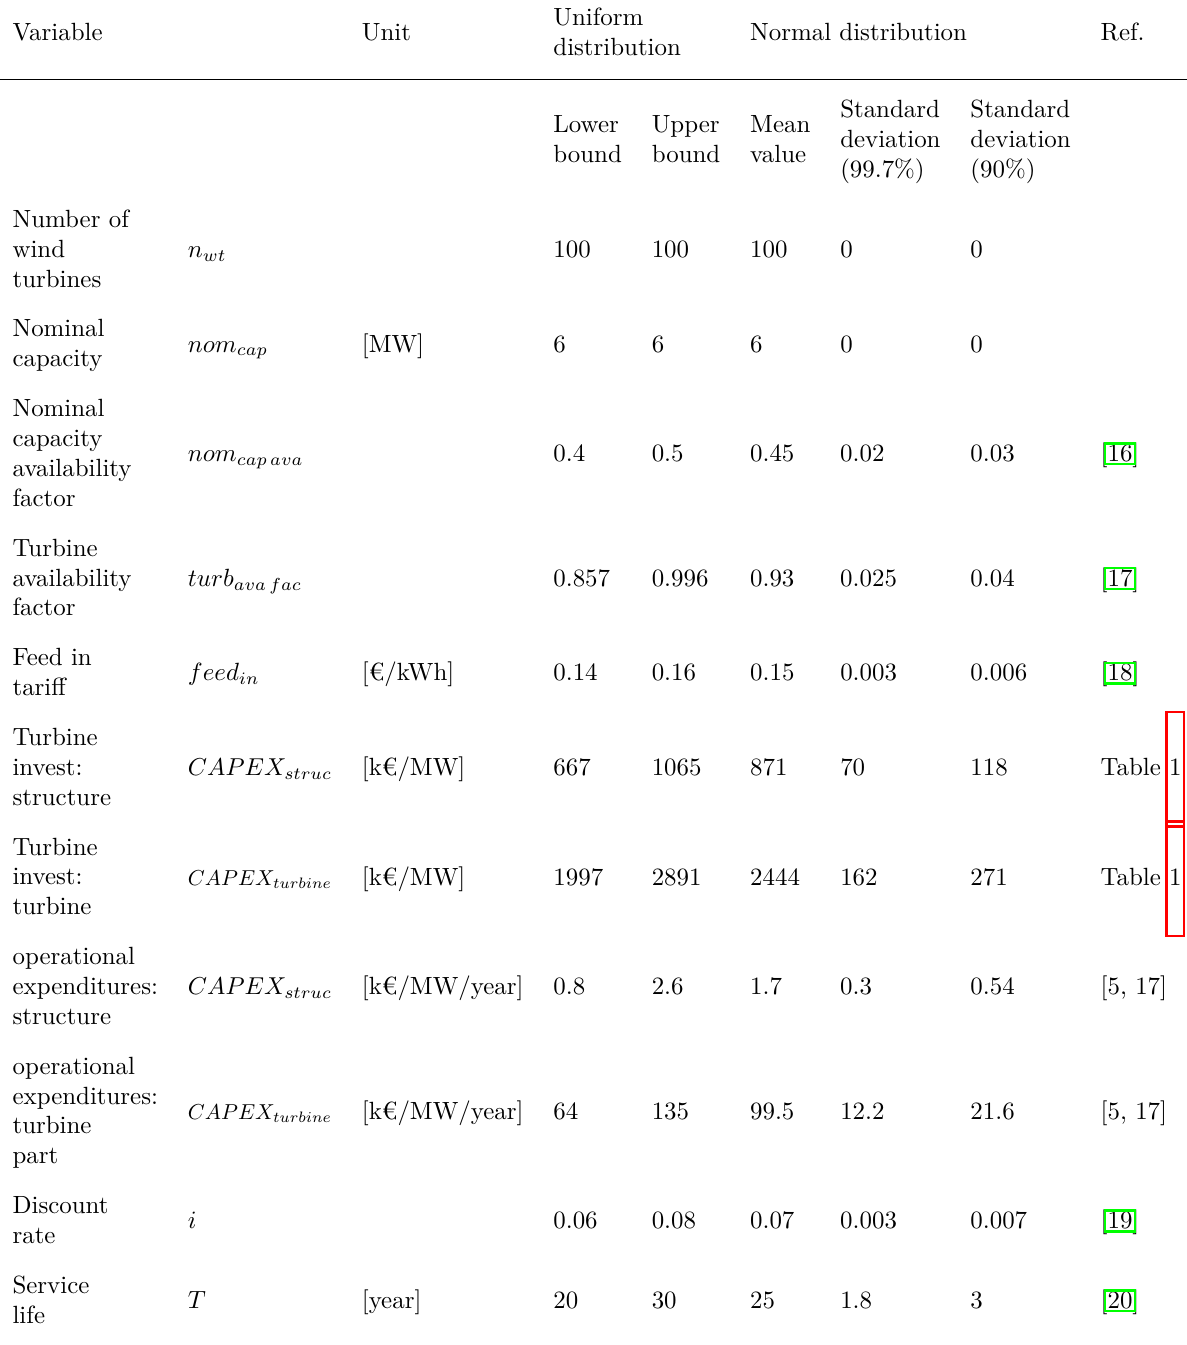
Table 5. Parameters of the probabilistic models applied in the sensitivity